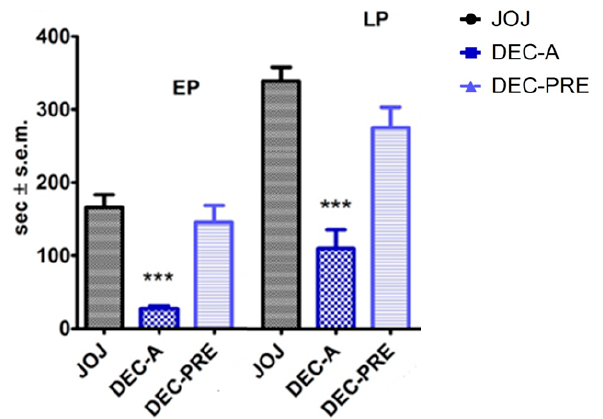
Figure 3. Analgesic effect of the transdermal administration of the decolored fraction of the essential oil of bergamot (DEC), enriched in D -limonene, on licking/biting behavior in the formalin test. The decolored fraction of the essential oil of bergamot (DEC), enriched in D -limonene, produced a reduction in the licking/biting behavior when administered immediately after formalin injection in the early and in the late phase (EP, LP) of the formalin test (DEC-A). The latter analgesic effect did not last after the 5 min pretreatment followed by washout (DEC-PRE). Overall licking/biting time is expressed as time in s ± SEM during the EP (0–10 min) and the LP (10–30 min). One-way ANOVA followed by Bonferroni test; n = 8; *** p < 0.001.